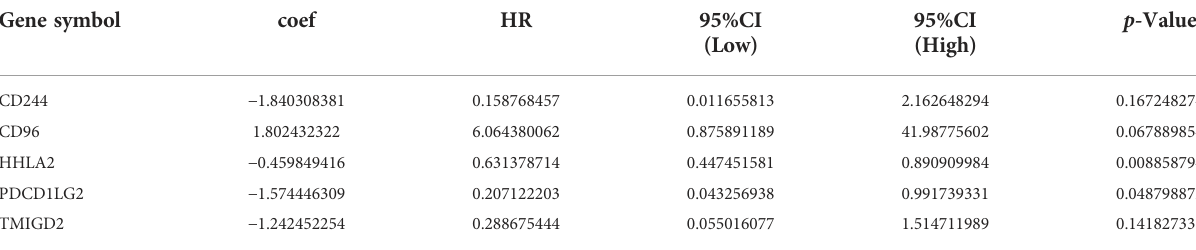
TABLE 2 Multivariate Cox regression of COL10A1 related